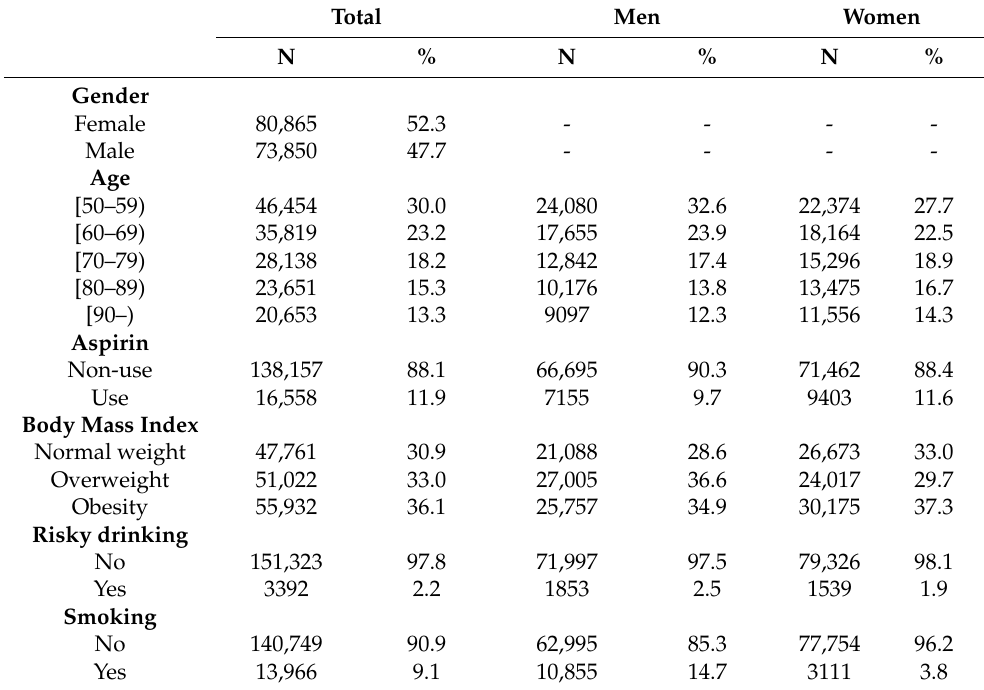
Table 1. General characteristics of the inhabitants included in this